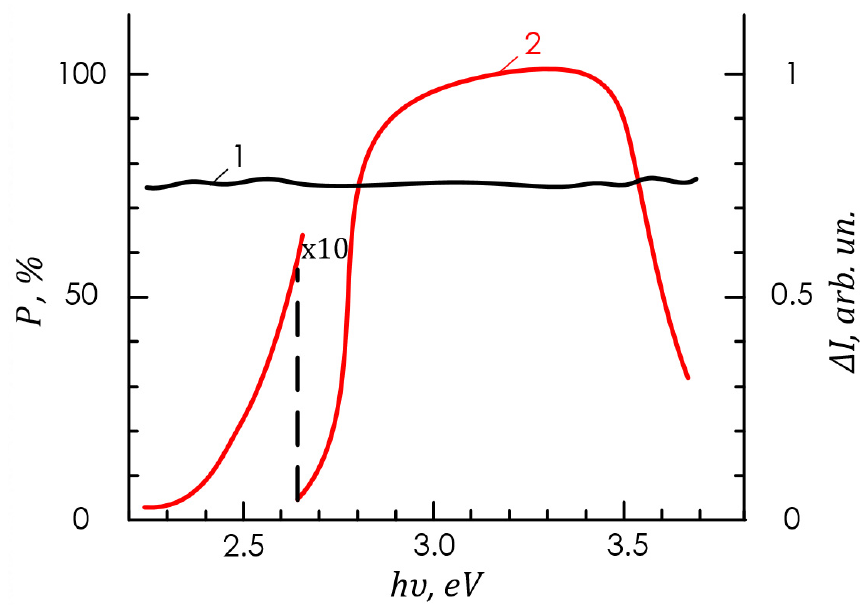
Figure 11. Spectral dependences of the PPL coefficient (1) and the polarization difference of photocur- rents (2) of Au-Pd-n-GaP surface-barrier structures (Sample No 5, T = 300 K, Ө = 80°).